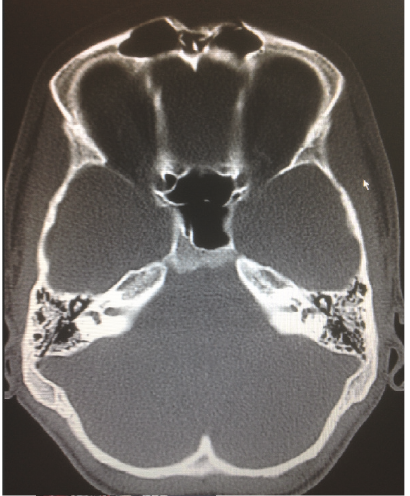
Figure 2: CT head demonstrating comminuted depressed fracture involving anterior wall of bilateral frontal sinuses and mildly displaced fracture of the nasal bones.